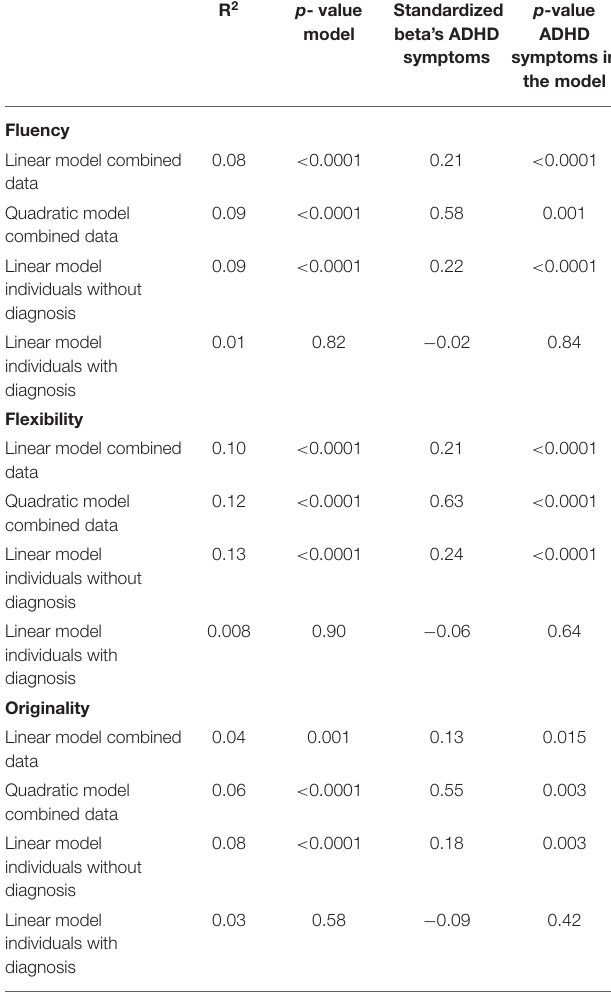
TABLE 6 | Overview of the output of the regression models for the relationship between divergent thinking and ADHD symptoms across the ADHD